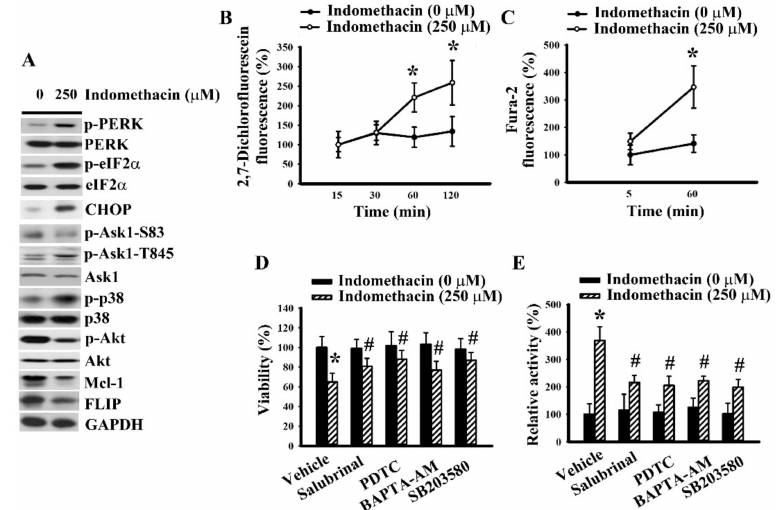
Figure 5. Indomethacin induced apoptosis in U87 cells. ( A ) U87 cells were treated with